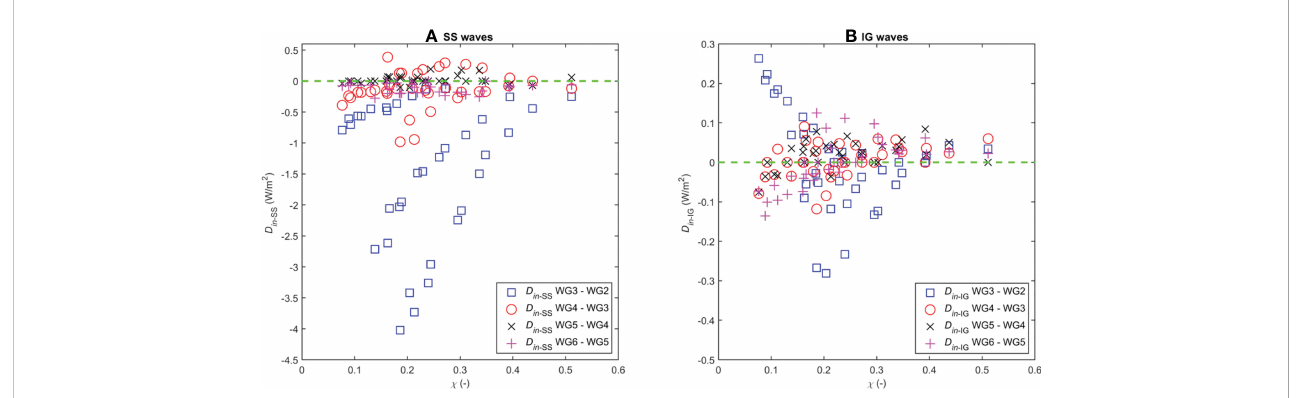
FIGURE 9 Energy dissipation versus relative submergence: (A) SS-waves; (B)